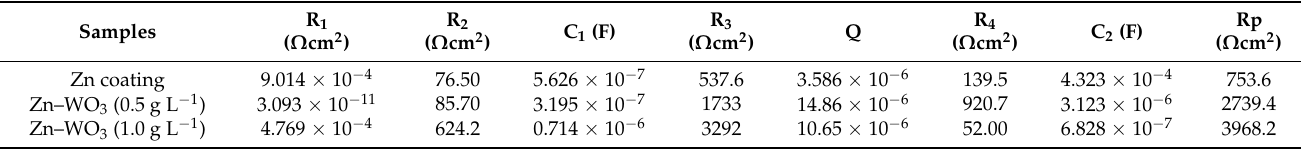
Table 3. Electrochemical parameters of the coatings derived from impedance spectra.